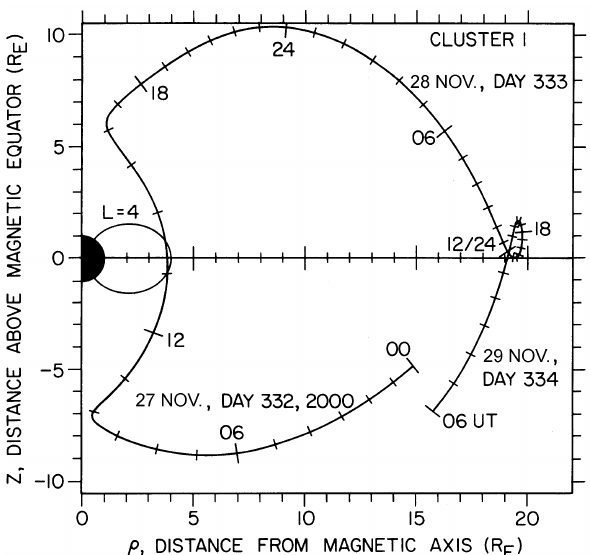
Fig. 1. A typical trajectory of the Cluster spacecraft in magnetic cylindrical coordinates. The coordinate Z is the distance above the magnetic equatorial plane, and the coordinate ρ is the distance from the magnetic axis, both in Earth radii, R E . For the orbit shown, which was on 27–29 November 2000, the spacecraft crossed through the magnetic equator near perigee at about 6.5hours Mag- netic Local Time (MLT), and near apogee at about 18.6hours MLT. For reference, a dipole magnetic field line is shown at L =